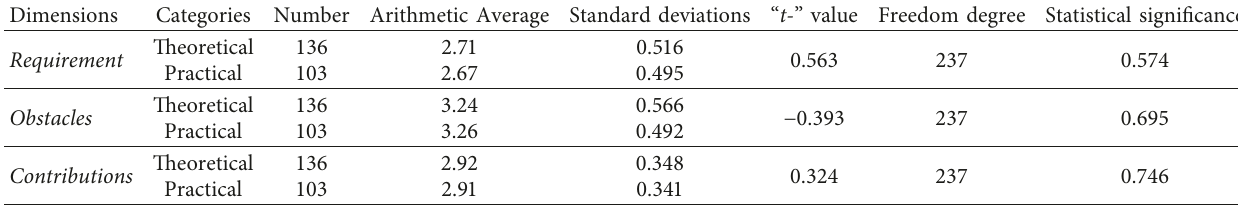
Table 9: Arithmetic averages, standard deviations, and t -tests for the impact of specialty on distant education requirements, difficulties, and proposed solutions in the face of university educational